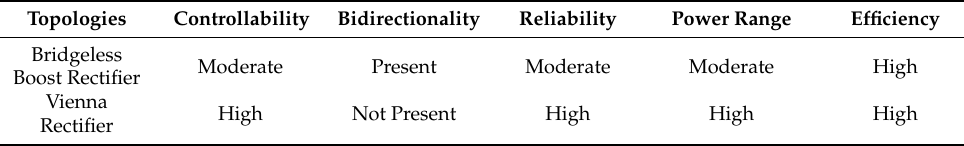
Table 8. Functionalities comparison of offboard rectifiers.